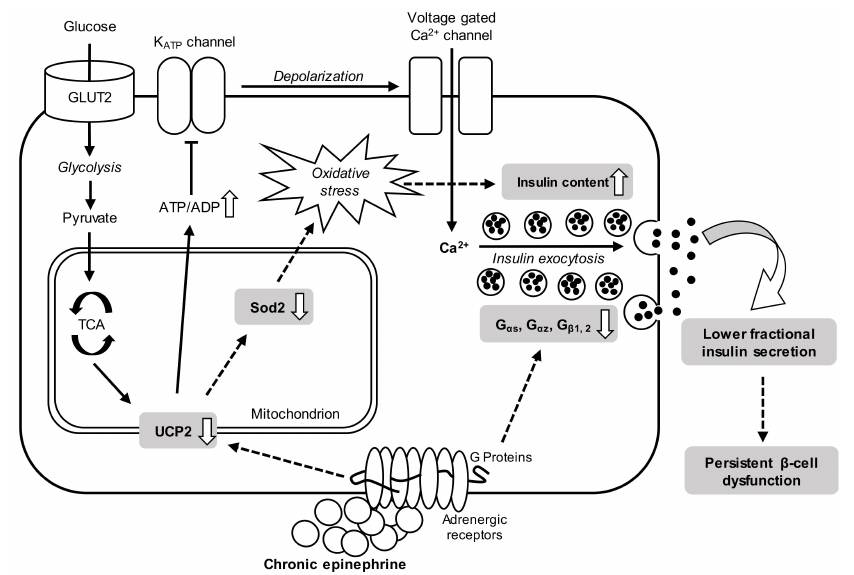
Figure 8. Summary of persistent β -cell dysfunction after chronic epinephrine exposure in pancreatic islets. The regulatory process of glucose stimulated insulin secretion is marked by solid arrows. Dash arrows indicate the physiological change and mRNA expression alteration associated with impairment of β -cell function after chronic epinephrine